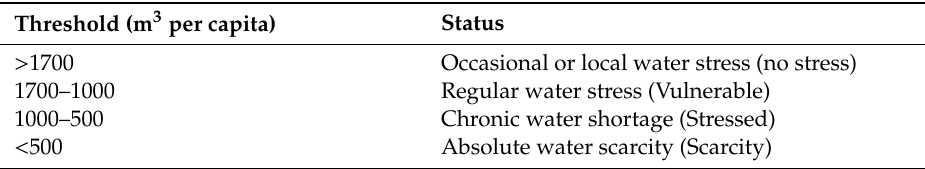
Table 1. Thresholds / indicator for water stress index (WSI) adapted from [6].